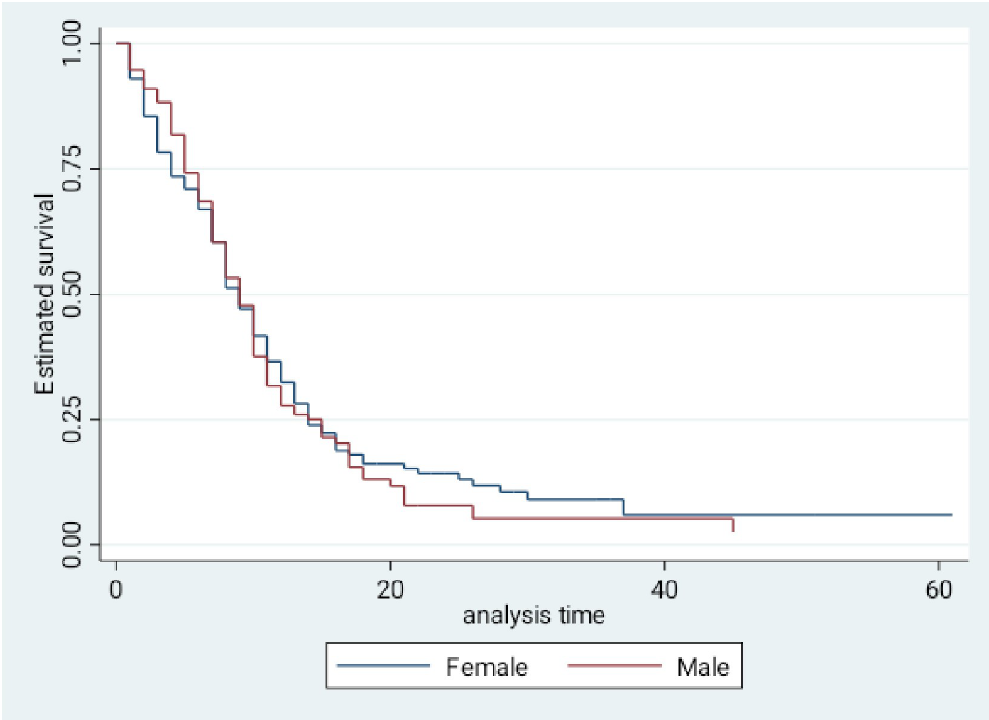
Fig 1. Kaplan-Meier product limit estimates of survival among COVID-19 patients admitted to the ICU.